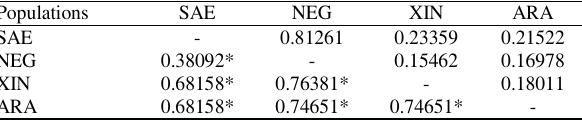
Table 4. Indirect estimate of genetic differentiation ( (cid:4) (lower diagonal) and gene flow (Nm) (upper diagonal) of Paratrygon aiereba . SAE= Solimões-Amazon River and Estuary, NEG= Negro River, XIN= Xingu River, ARA= Araguaia River. * Level of significance P < 0.008; (after Bonferroni